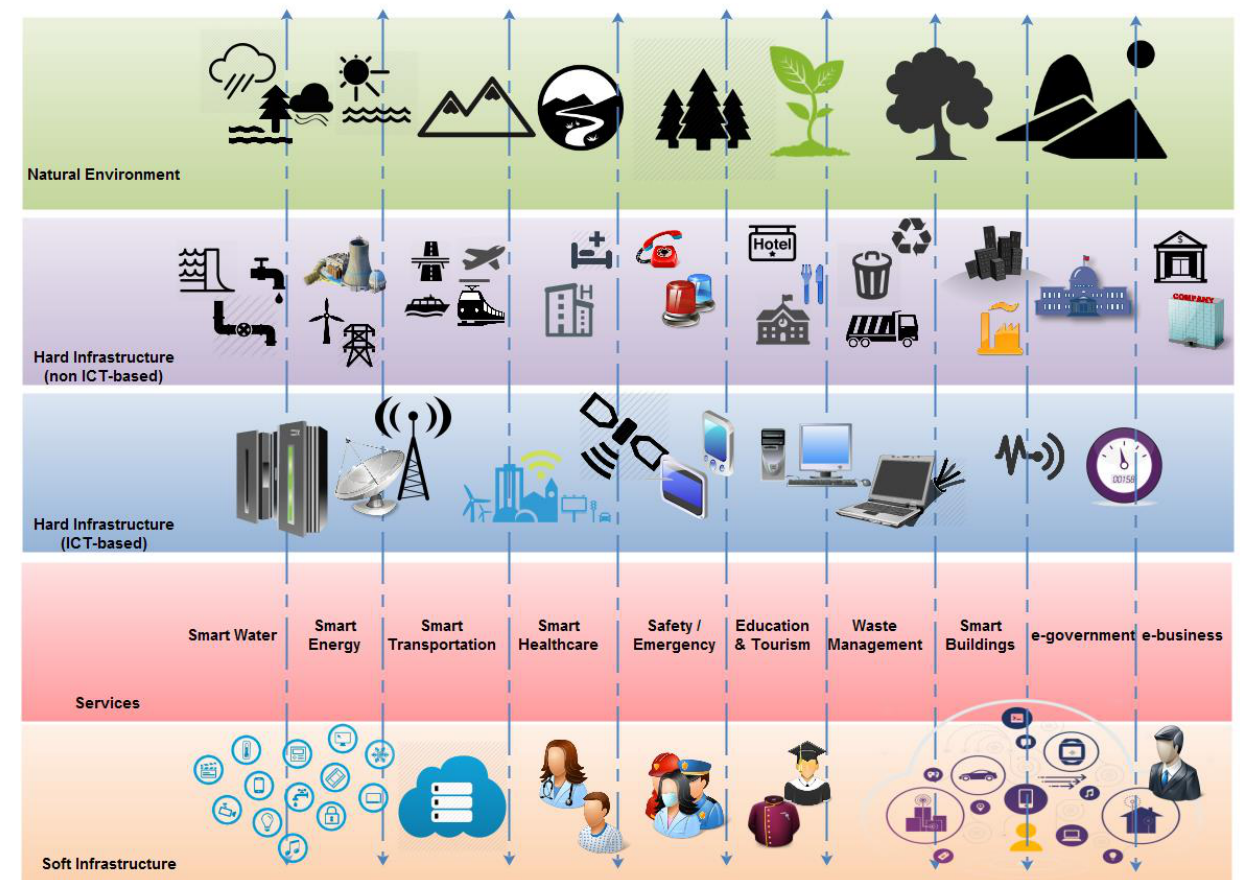
Figure 1. A smart city ’ s generic multi-tiered ICT architecture [4].